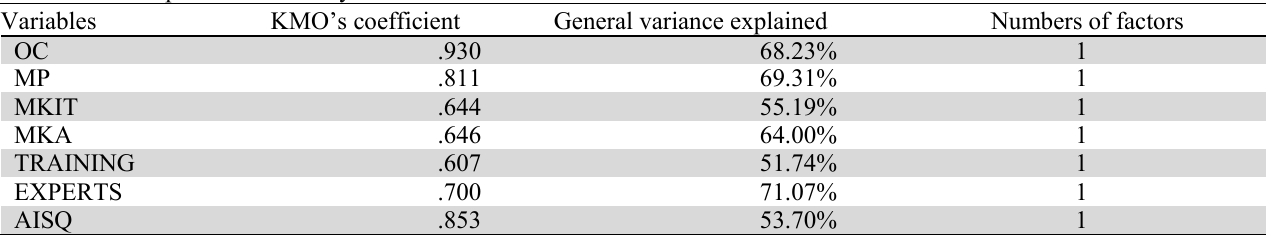
Results from explore factors